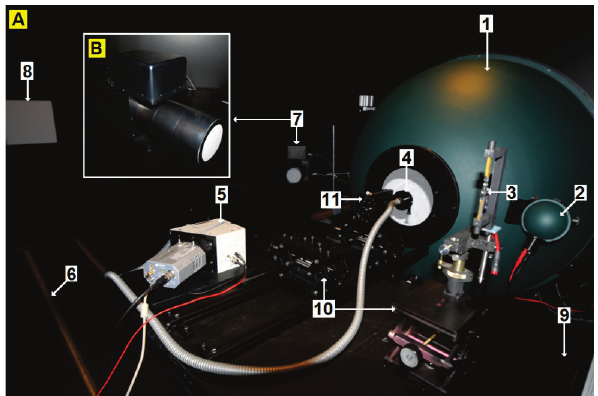
Figure 1. Experimental setup at the UNIS calibration lab. (a) (1) Labsphere 1m diameter low light level integrating sphere, (2) source sphere with tungsten lamp, (3) 45W tungsten lamp, (4) FICS fiber bundle probe, (5) FICS, (6) rail road, (7) Keo Alcor-RC low light source, (8) Lambertian screen, (9) height adjustable table on rails, (10) table jacks and (11) rotary probe mount. (b) Keo Alcor-RC low light source. Table 1. Oriel 45W tungsten lamp certificate (s/n 7-1867). The spectral irradiance values are measured at a distance of z 0 = 0 . 5m.